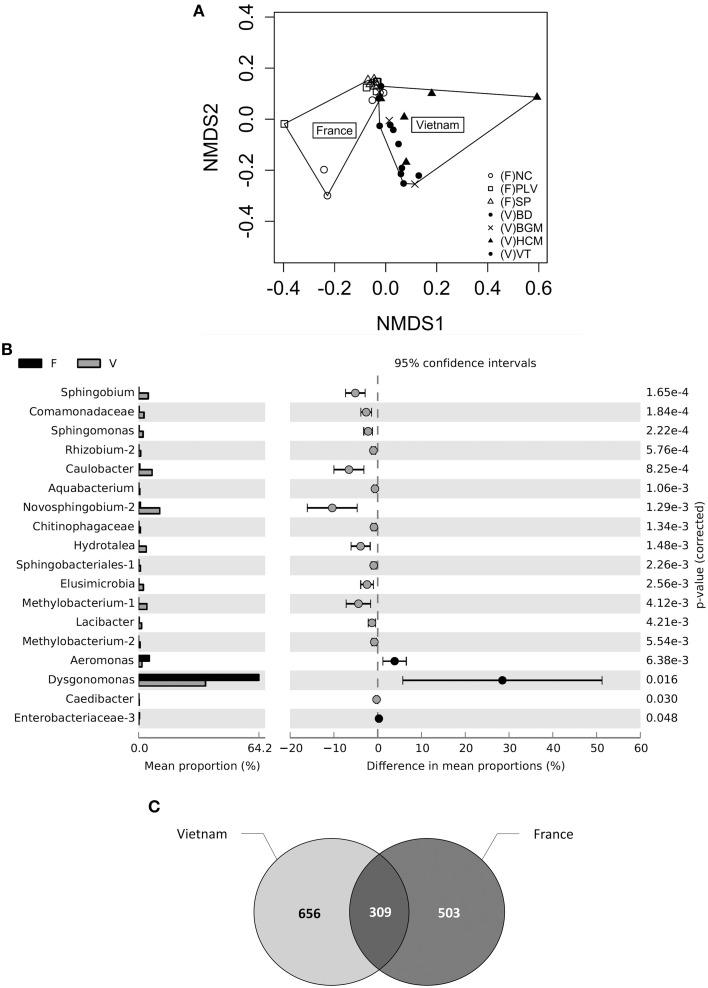
Community structure and OTU-country associations. (A) Non-Metric Multidimentional Scaling plot represents Bray-Curtis β-diversity structure among individuals and populations. The loss function Stress = 0.09 and correlation with true distances R2 = 0.97. NC, Nice; PLV, Porte-lès-Valence; SP, Saint Priest; VT, Vung Tàu City; HCM, Hồ Chí Minh City; BD, Bình Du'o'ng; BGM, Bù Gia Mâp. (B) Difference in OTU abundance between midgut bacterial microbiota of French and Vietnamese Ae. albopictus. Display represents extended error bars of significant fold-changes (P>0.05) between midgut samples from France (F) and Vietnam (V). (C) Venn diagram representing shared OTUs between midgut samples from France and Vietnam. The intersection of both circles represents the number of shared OTUs between France and Vietnam. To avoid size effect, sequences were merged per group, and then subsampled.